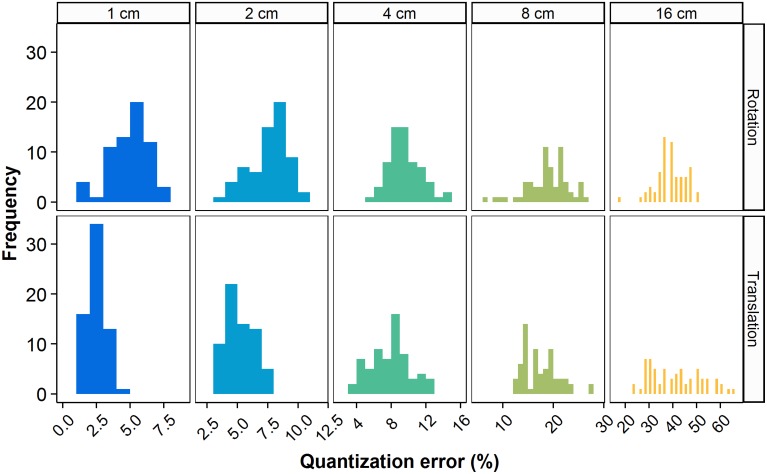
Relative quantization error for the representative Berberis thunbergii plant shown in Figure 3. Box-counts from the first 64 rotations (top) and the first 64 translations (bottom) are shown independently at each box size.